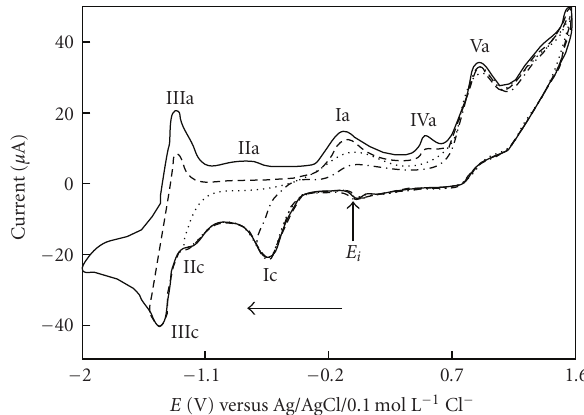
Figure 3: Cyclic voltammograms of isolapachol, DMF+ 0.1mol L − 1 TBAP, GCE versus Ag/AgCl /0.1 molL − 1 NaCl, c = 2 mmolL − 1 . (solid line), Initial potential = 0V, v = 0 : 100 Vs − 1 . Negative scan. di ff erent E λ : (dashed dotted line) − 0.739 V; (dotted